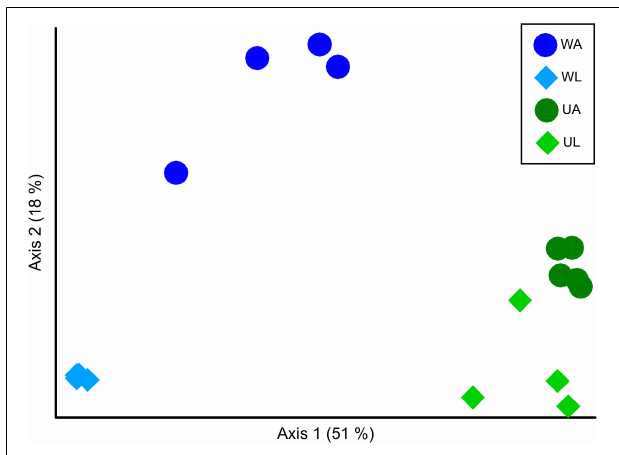
FIGURE 4 | Beta diversity analysis in ordination plot (PCoA) of the Bray–Curtis dissimilarity matrix, of bacterial communities associated with Ulva [UA, Ulva from aquaculture (dark green circles); UL, Ulva from lagoon (light green diamonds)] and in seawater [WA, water from aquaculture (dark blue circles); WL, water from lagoon (light blue diamonds).